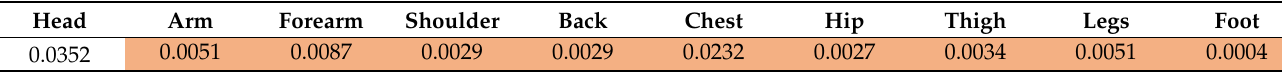
Table 15. p -value of the thermal comfort.